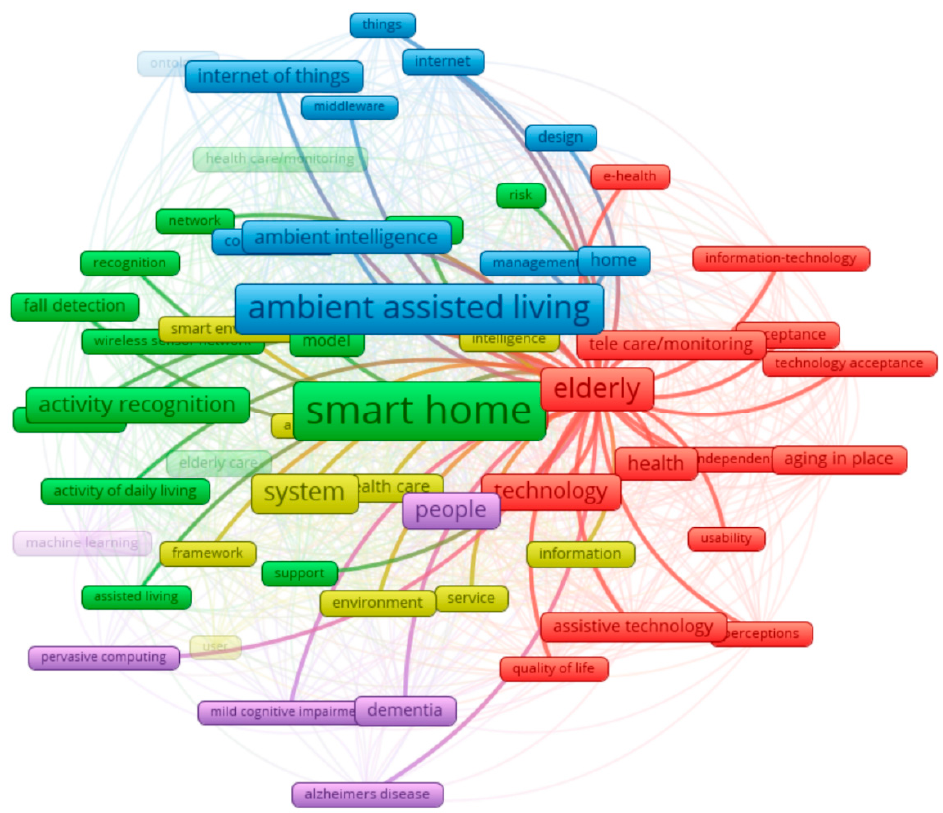
Figure 3. Clustering the keywords from ISI WOK records for the “Smart Furniture” phrase by Topic.